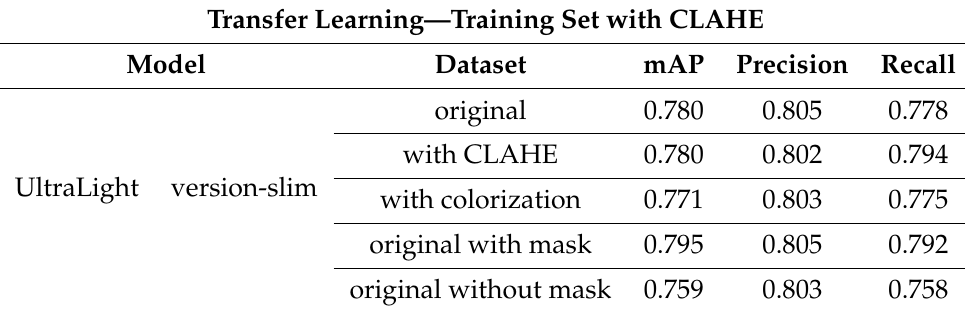
Table 5. Results obtained for testing model trained on own dataset with